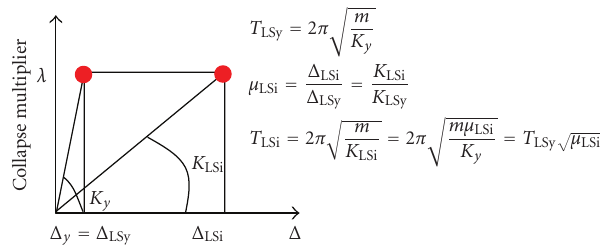
Figure 1: Capacity curve illustrating elastic perfectly-plastic struc- tural behaviour and the displacement capacity at di ff erent limit states ( Δ LSi ), the collapse multiplier ( λ ), and secant sti ff ness ( K i